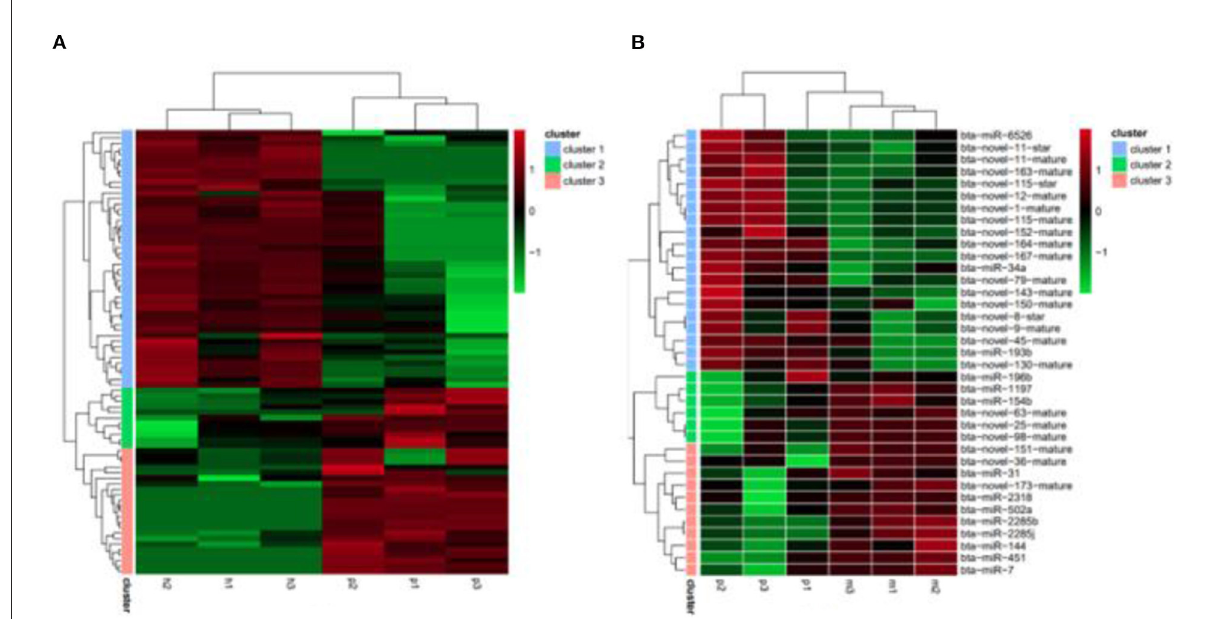
FIGURE5 Heatmap of clustering analysis and differentially expression of H vs. P and M vs. P. (A) Heatmap of differentially expression analysis of H vs. P. (B) Heatmap of differentially expression analysis of M vs. P. Red represents the high expression of miRNA of each comparison group, and green represents the low ones.